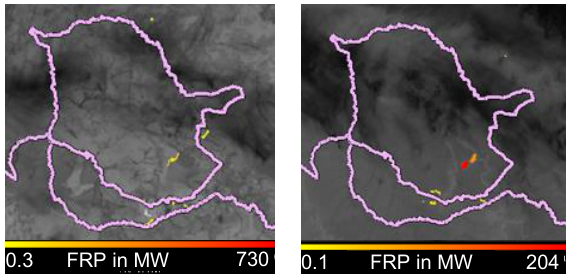
Figure 1. FireBird FRP map of fires in a protected area in central Brazil (purple outline) obtained by TET-1 on 2014/10/17 at local noon (left) ad near midnight (right). The FRP value of the fire clusters is colour coded – see scale.